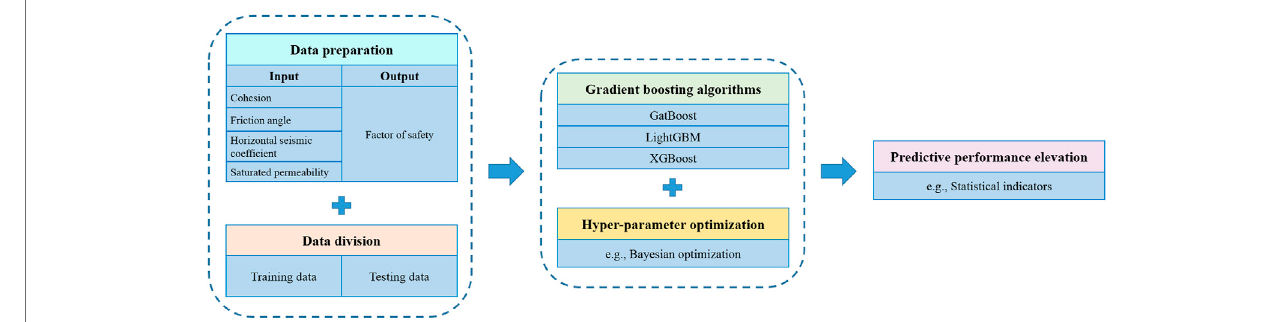
FIGURE 1 | Implementation procedure of the proposed method.